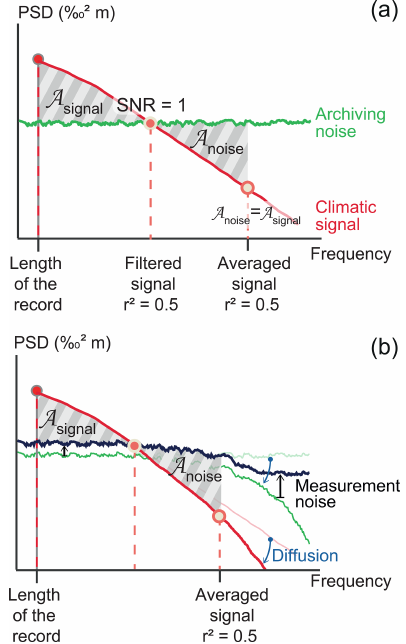
Figure 1. Schematic of the signal-to-noise ratio (SNR) estimate us- ing the power spectral density (PSD): (a) idealized PSD of the cli- matic signal (red) and of the archiving noise (green) which consists of noise induced by precipitation intermittency and stratigraphic noise; (b) impact on the same PSDs of the effect of diffusion (light colours: before diffusion; dark colours: after diffusion) and of mea- surement noise